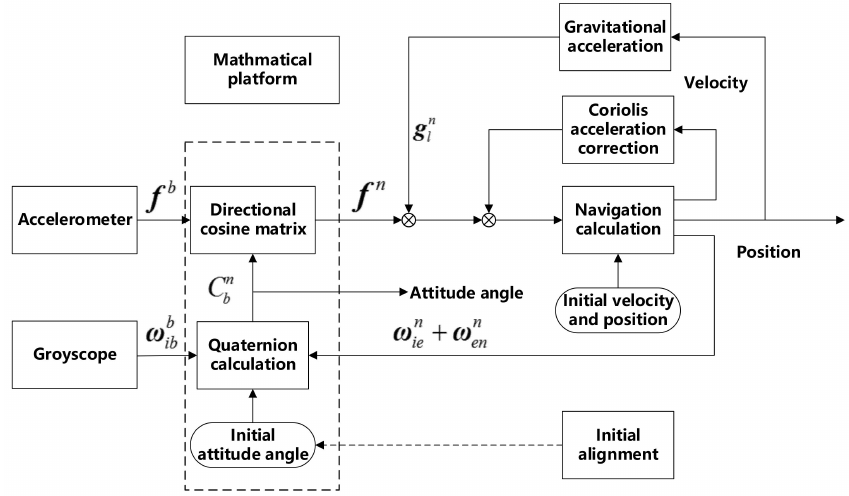
Figure 13. Calculation schematic diagram of the strapdown inertial navigation